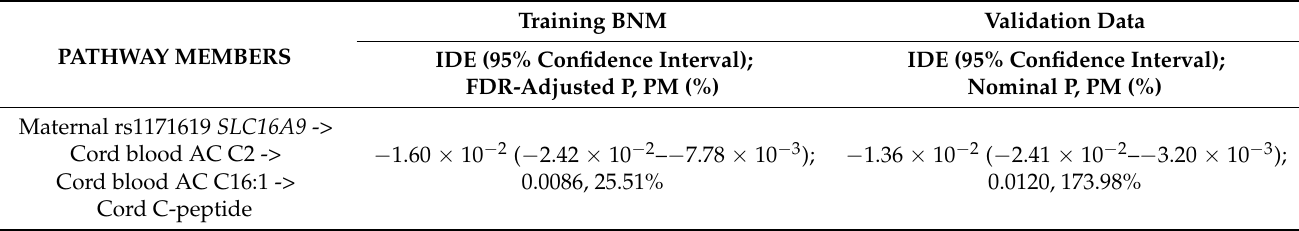
Figure 3. Subgraph of 1-hr BNM highlighting four potential SMM pathway. Nodes represent the metabolite, genotype and phenotype variables and edges represent the conditional dependencies between them. The maternal features are represented by square nodes and the offspring features are represented by circle nodes. Newborn outcome variables are grey, genotypes are green, and the remaining colors correspond to different metabolite classes. The solid, red edges correspond to the four purported SMM pathways involving 1-hr metabolites with statistically significant IDE after FDR correction and positive proportion mediated in the training data set, with nominal significance and positive PM confirmed in the validation data set. Dashed, grey edges correspond to nodes adjacent to the SMM pathways. AA, amino acid; AC, acylcarnitine; CHO, carbohydrate; FA, fatty acid; GC/TCA, glycolysis/tricarboxylic acid cycle; OA, organic acid; PUR/PYR, purine or pyrimidine. Table 2. Individual ordered pathways from Bayesian Network Models (BNMs) demonstrating statistically significant serial mediation in training and validation data sets.